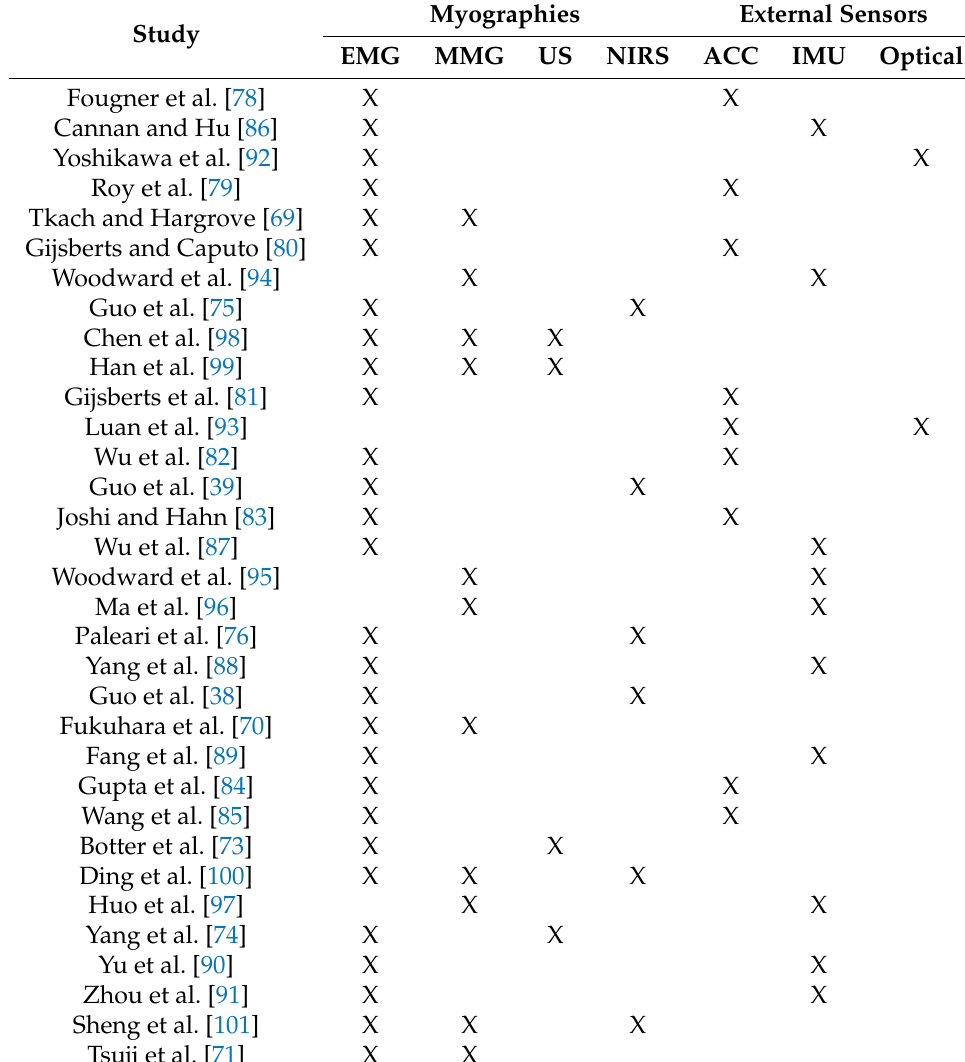
Table 3. Distribution of studies based on the topic included in each study. “X” denotes the topic included in that